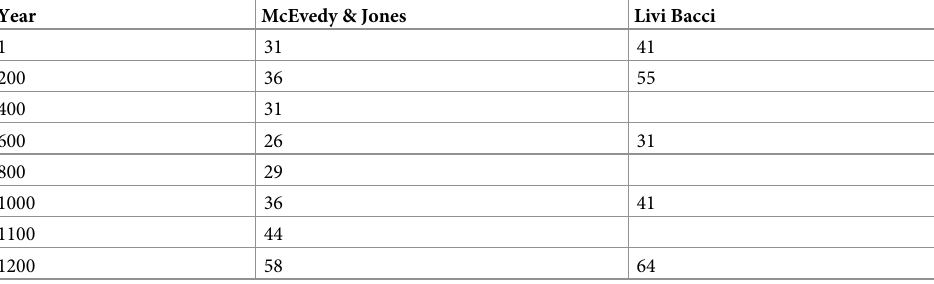
Table 3. Population estimates for Europe (millions).